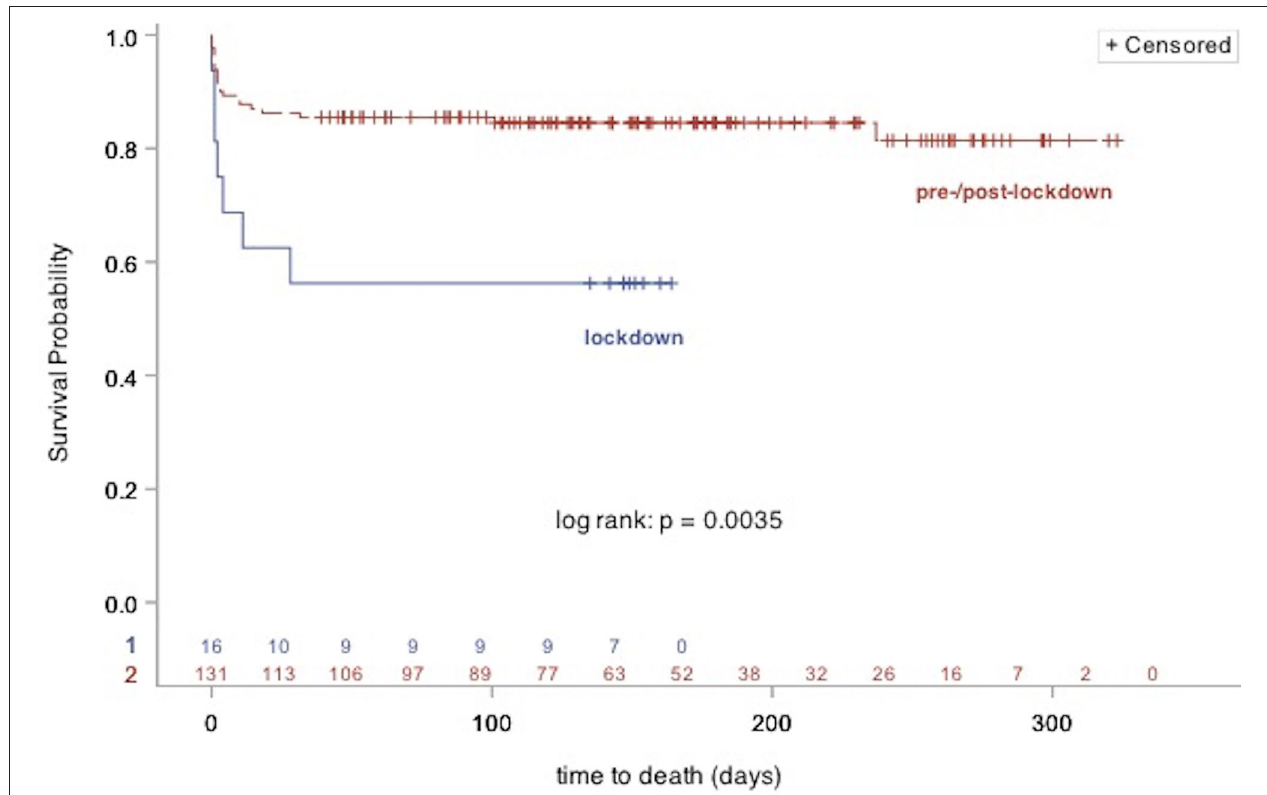
FIGURE 1 | Kaplan Meier plot showing survival of STEMI patients admitted during (lockdown group), and outside of COVID-19 associated lockdown (pre-/post-lockdown group).